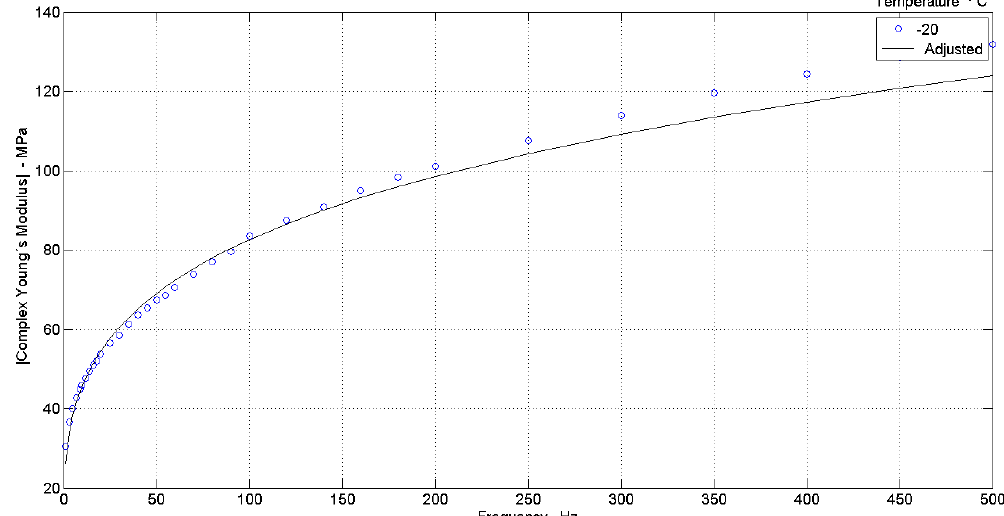
Figure 3. Variation of Complex Young’s modulus (experimental data “o”) for (adjusted curve by model parameters “ − ”), T = − 20 ◦ C, ε = − 0.07 ( λ = 0.95) [29].